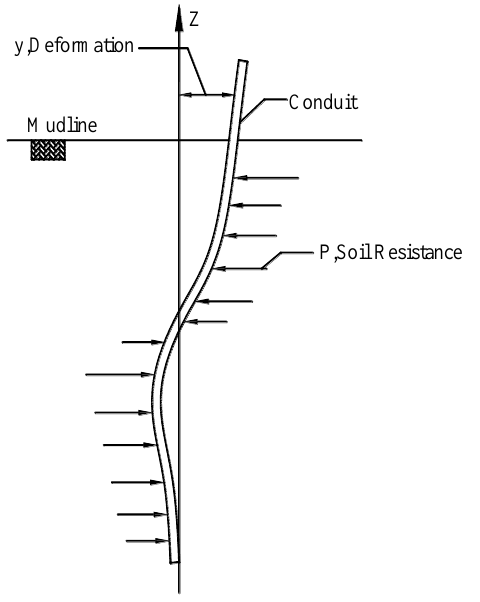
Figure 3. Soil load acting on the